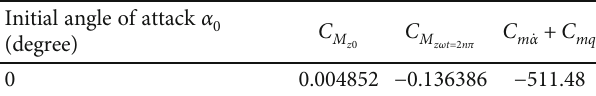
Table 1: Longitudinal combined dynamic